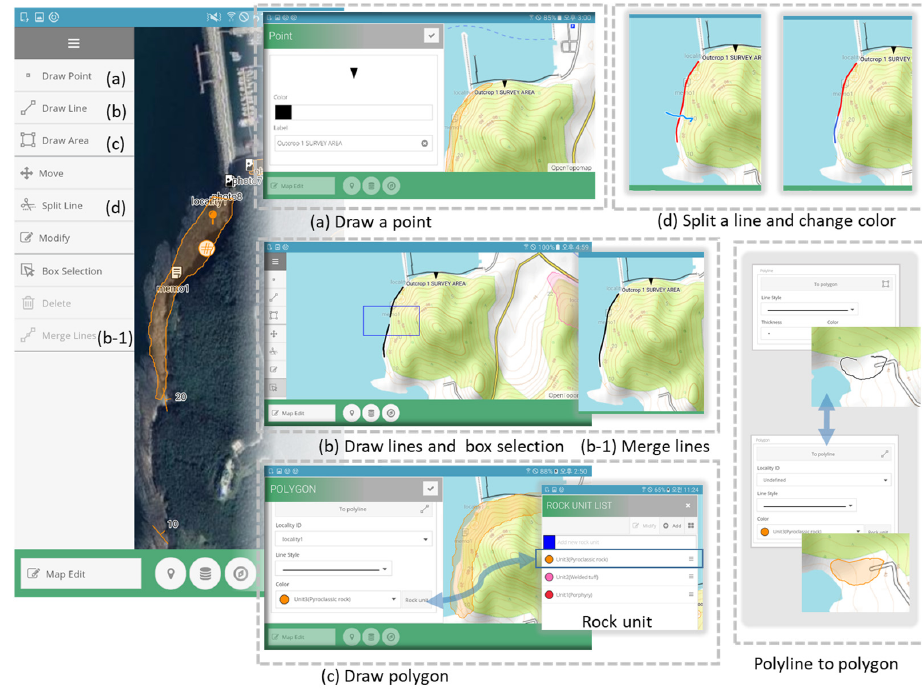
Figure 5. Map editing tools and functions: ( a ) point creation for label entry, ( b ) line drawing and box selection with line merge (two to one), ( c ) polygon drawing panel and associated rock units, and ( d ) line splitting and color control.